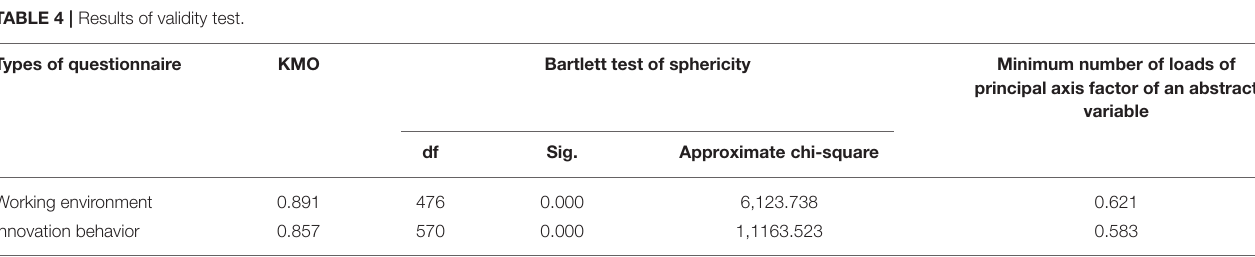
TABLE 4 | Results of validity